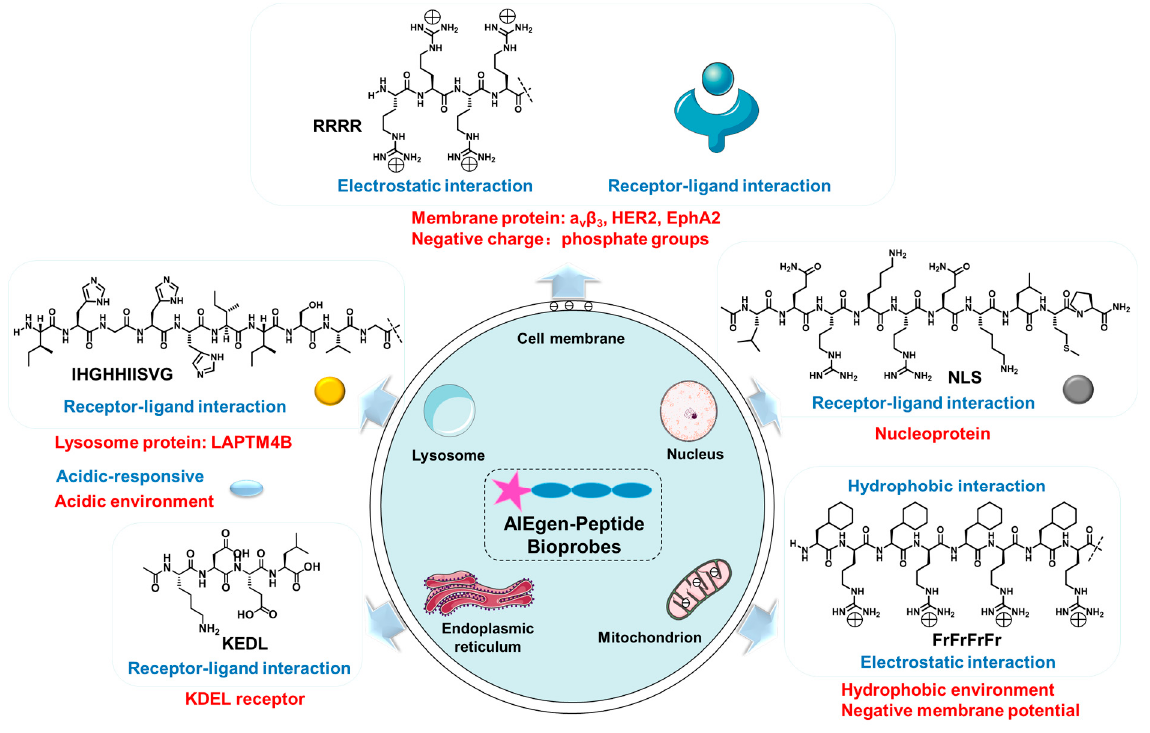
Figure 1. The mechanism of bioprobes-targeting organelles.